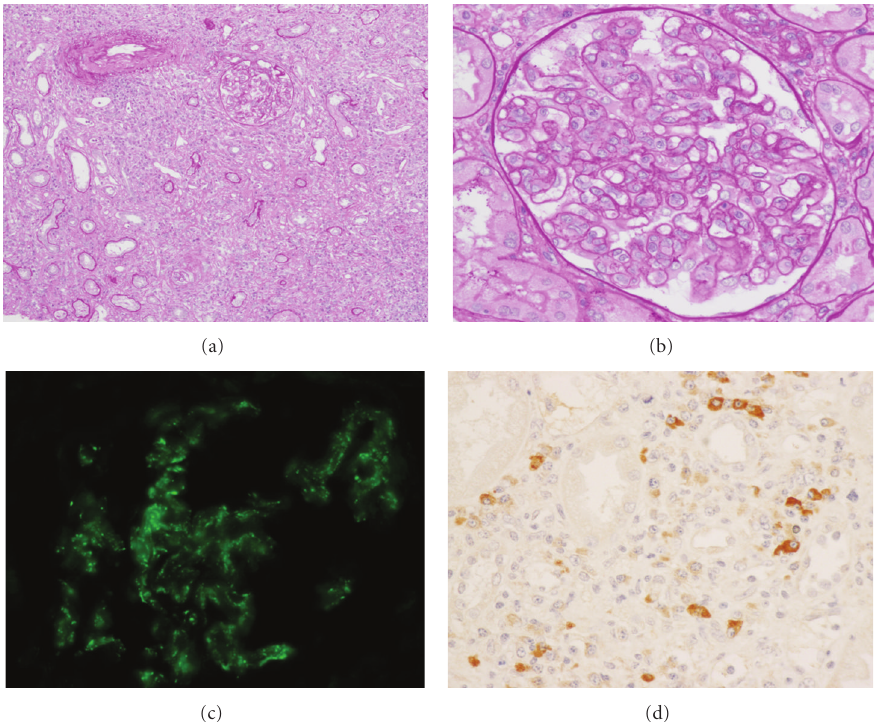
Figure 2: IgG4-related tubulointerstitial nephritis with Henoch-Sch¨onlein purpura nephritis. (a) Periodic acid-Schi ff (PAS) staining reveals severe tubulointerstitial nephritis (PAS × 100). (b) Global endocapillary proliferation is evident (PAS × 400). (c) Immunofluorescence staining for C3 reveals mesangial and capillary wall deposits ( × 400). (d) Many IgG4+ plasma cells are seen in the interstitium (IgG4 × 400).